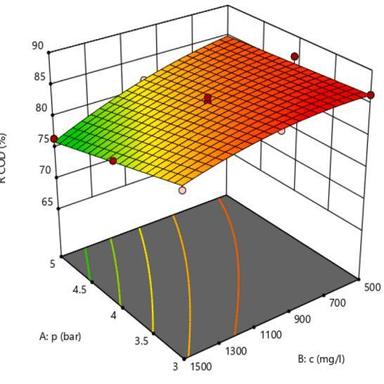
Plots of (a) 3D surface in dark condition; (b) 3D surface in light irradiation; (c) predicted vs. actual values for dye removal response.